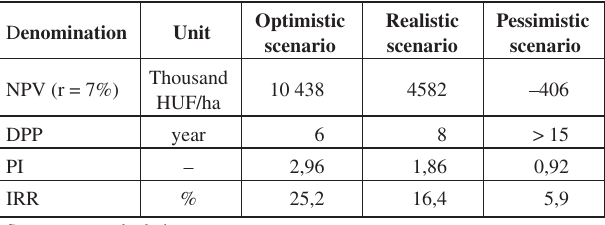
Table 9. Investment Efficiency in German Apple Production Regarding Investment